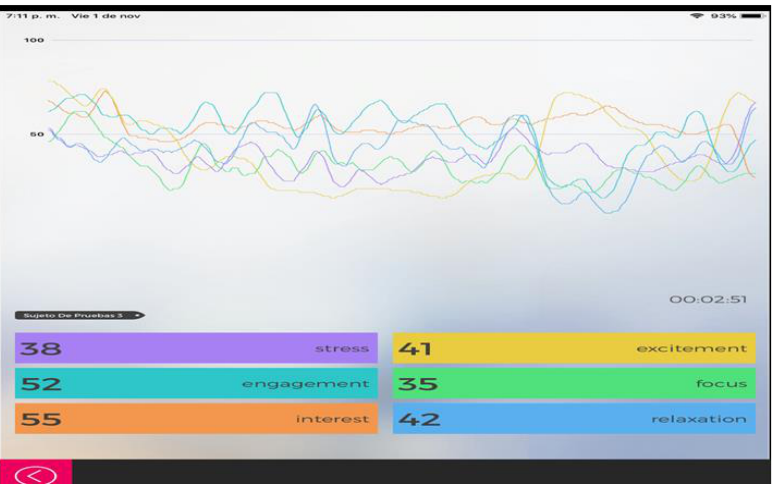
Figure 4. EEG used to collect data on real emotions.